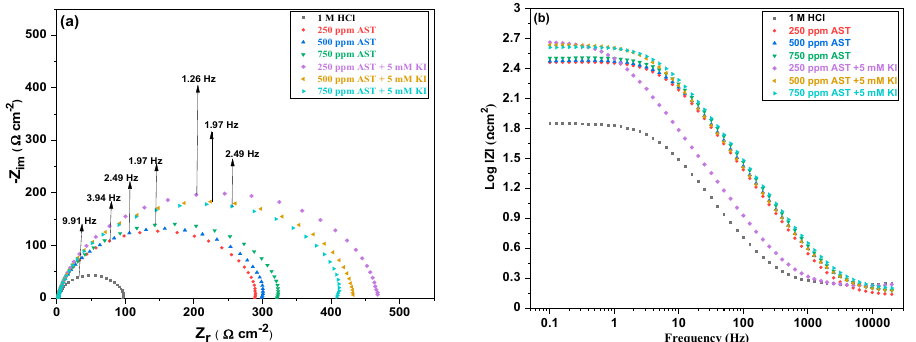
Figure 6. ( a ) Nyquist and ( b ) Bode plots for C1018 carbon steel in 1 M HCl with various concentrations of AST inhibitors and AST + KI.